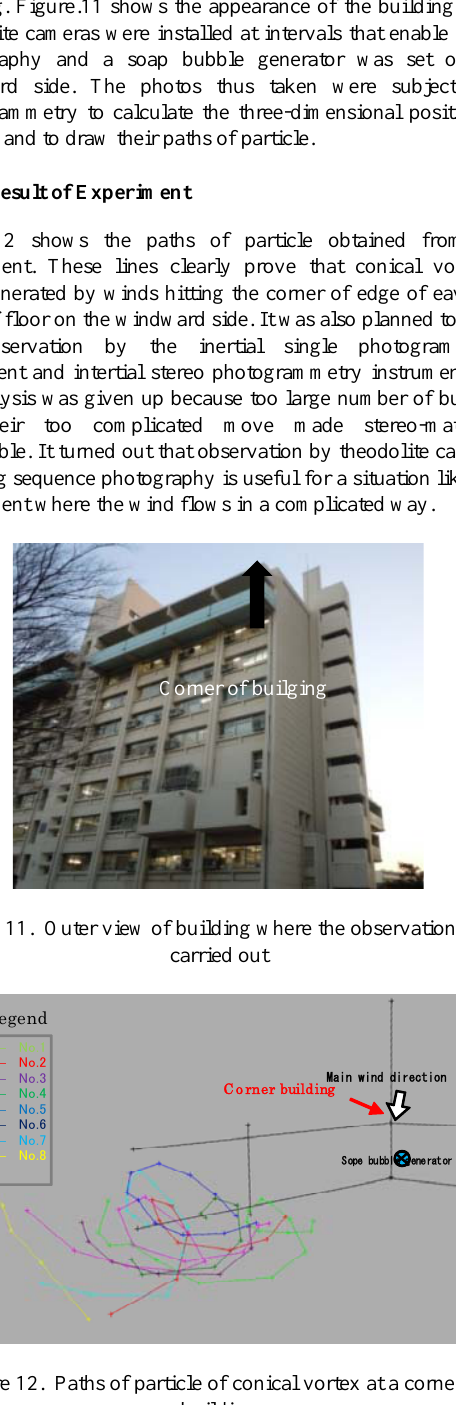
Figure 12. Paths of particle of conical vortex at a corner of building